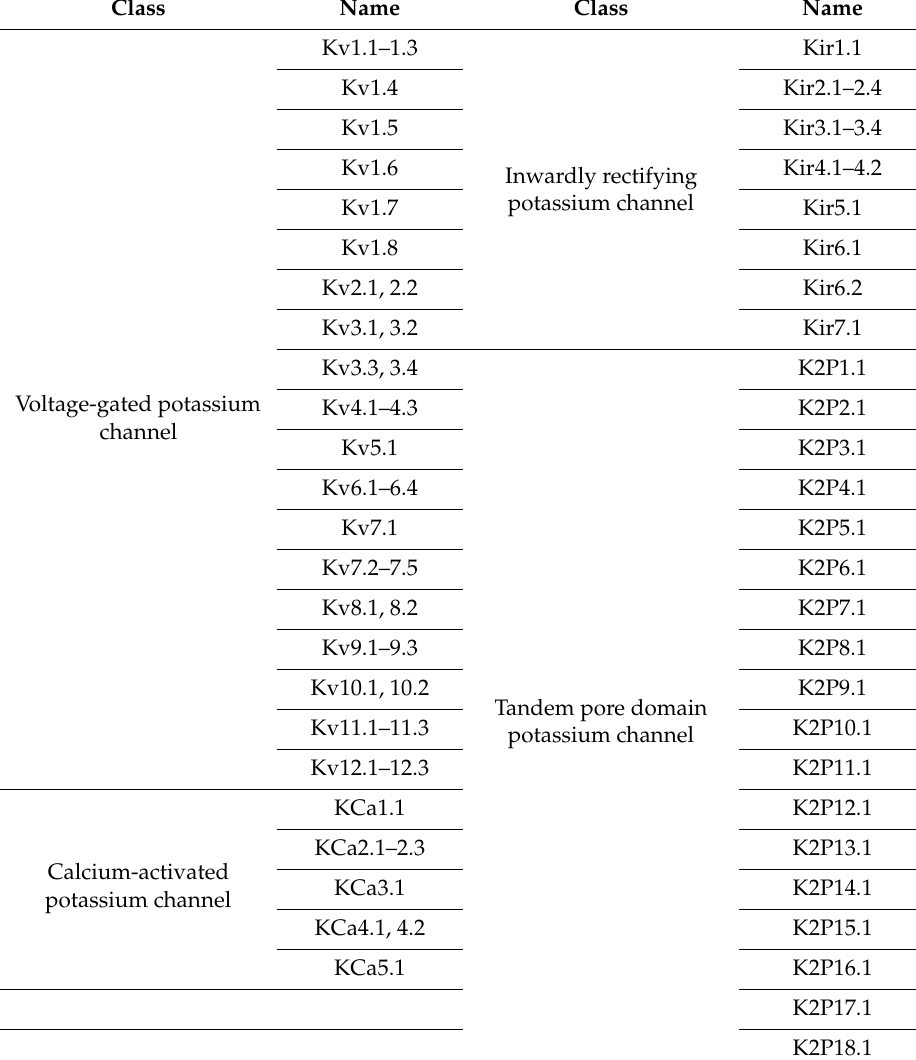
Table 1. Classification of potassium